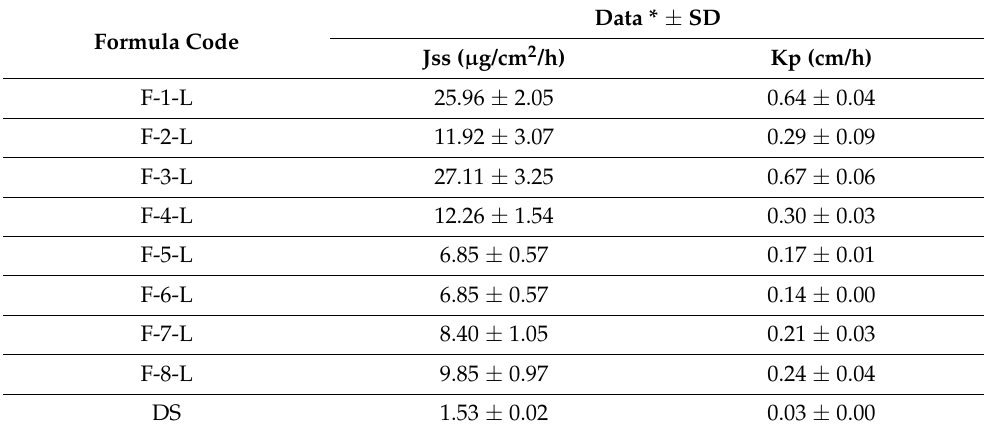
Table 5. The results of permeation parameters of TRAVO-loaded LCNs.